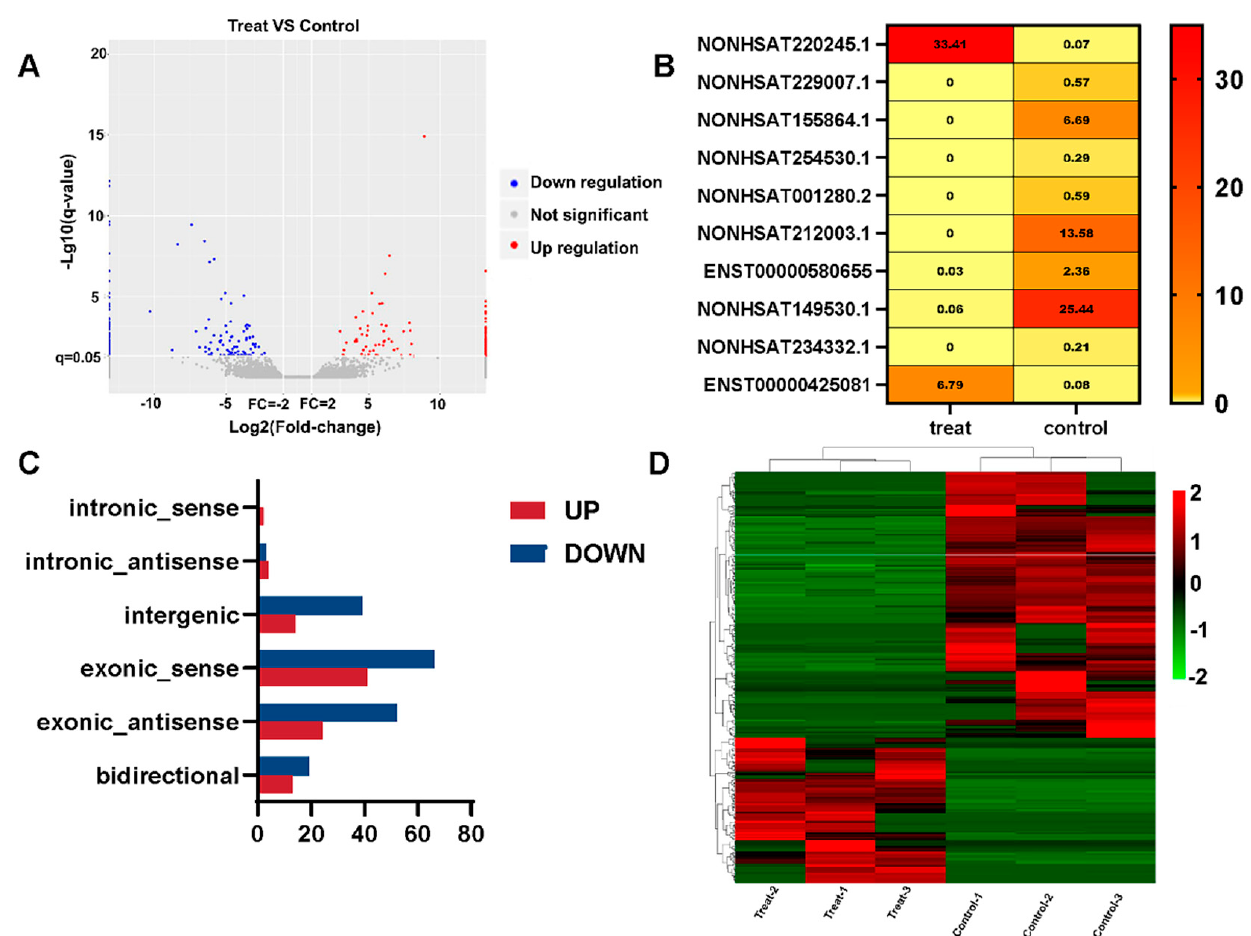
Figure 2. lncRNA differential expression analysis of TiO 2 NPs. ( A ) The number of upregulated and downregulated genes in the treatment group is shown on a volcano map of differentially expressed genes; ( B ) the top 10 lncRNAs with the lowest q value in the treatment group and the control group are displayed in the heatmap, and the FPKM value of each lncRNA is displayed. The FPKM value is represented by different colors, with yellow to red values increasing; ( C ) the relative expression of differential lncRNAs is shown in a histogram. The downregulated genes are shown in blue, while the upregulated genes are represented in red; ( D ) the distinctive differences between the treatment group and control group are shown via a heatmap of cluster analysis. The downregulated genes are shown in green, while the upregulated genes are represented in red.